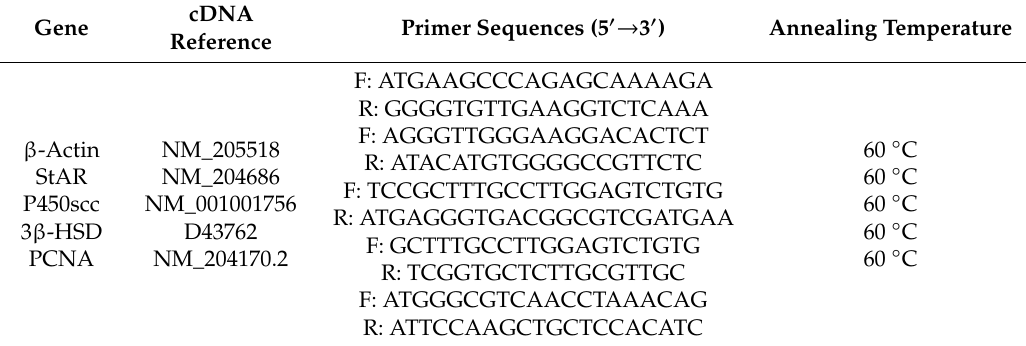
Table 1. The primer sequences used in the present